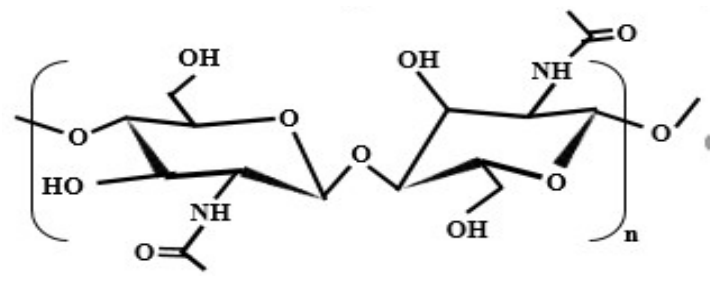
Figure 3. The chemical structure of chitin.